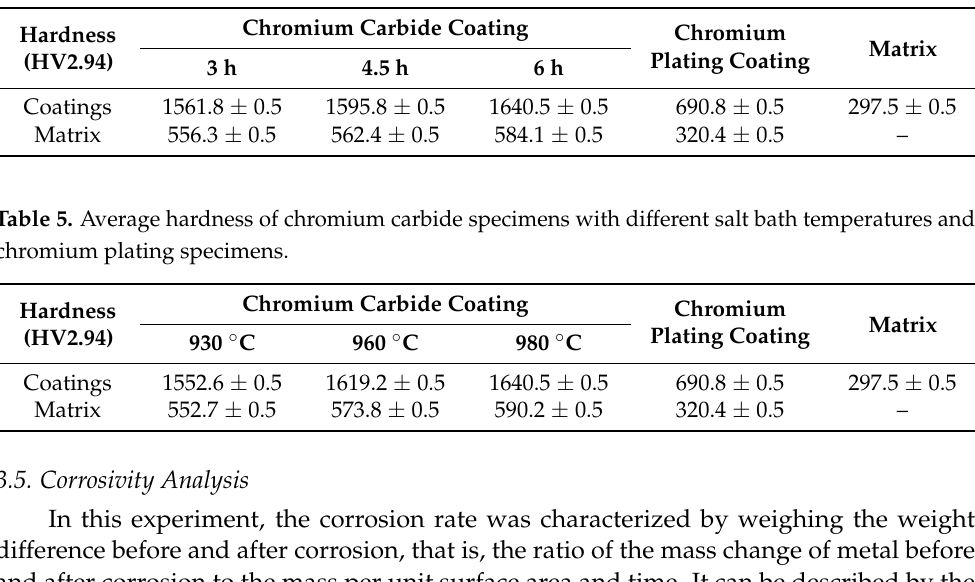
Table 4. Average hardness of chromium carbide specimens with different salt bath times and chromium plating specimens.